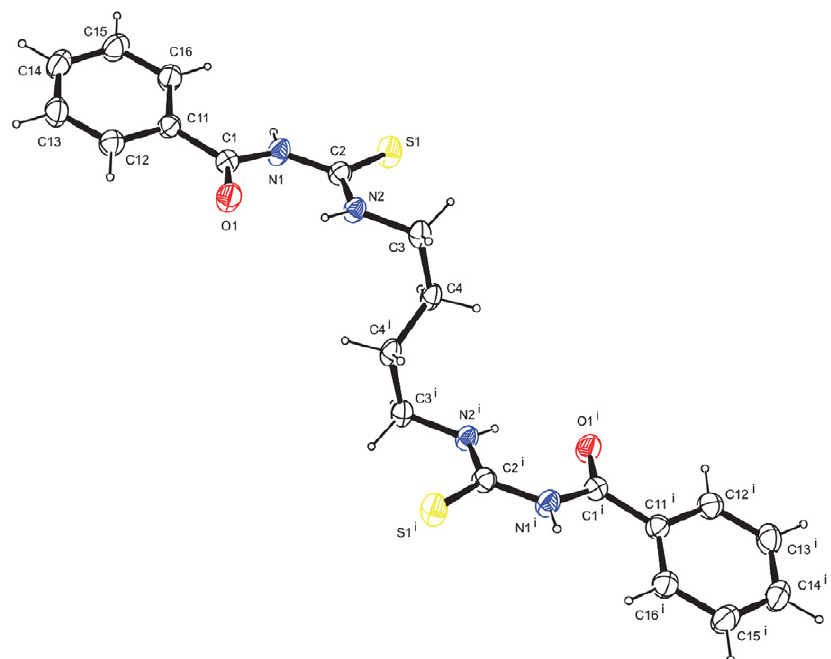
Figure 4. An ORTEP view of 3-benzoyl-1-(4-{[(phenylformamido)methanethioyl]amino}butyl)thiourea ( 14 ) showing 50% probability displace- ment ellipsoids and atom